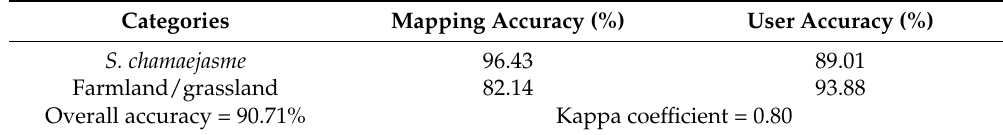
Table 4. Classification accuracy